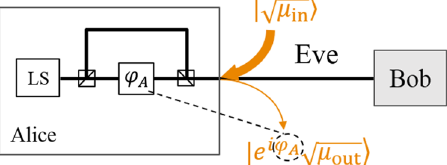
FIG. 2. Schematics of the transmitting unit of a unidirectional fiber-based QKD setup and Eve ’ s THA. LS is a generic light source. The square with φ A is the encoding device. It writes the phase information φ A on photons traveling in the short arm of the interferometer. Eve injects a bright light pulse in the coherent ffiffiffiffiffiffi p μ state j i into Alice ’ s module. A fraction of it is encoded by in ffiffiffiffiffiffiffiffi p μ Alice and back-reflected to Eve, emerging as j e i φ A i , i.e., out γμ attenuated by a factor γ ( μ ) but containing the phase out ¼ in information φ A (dashed